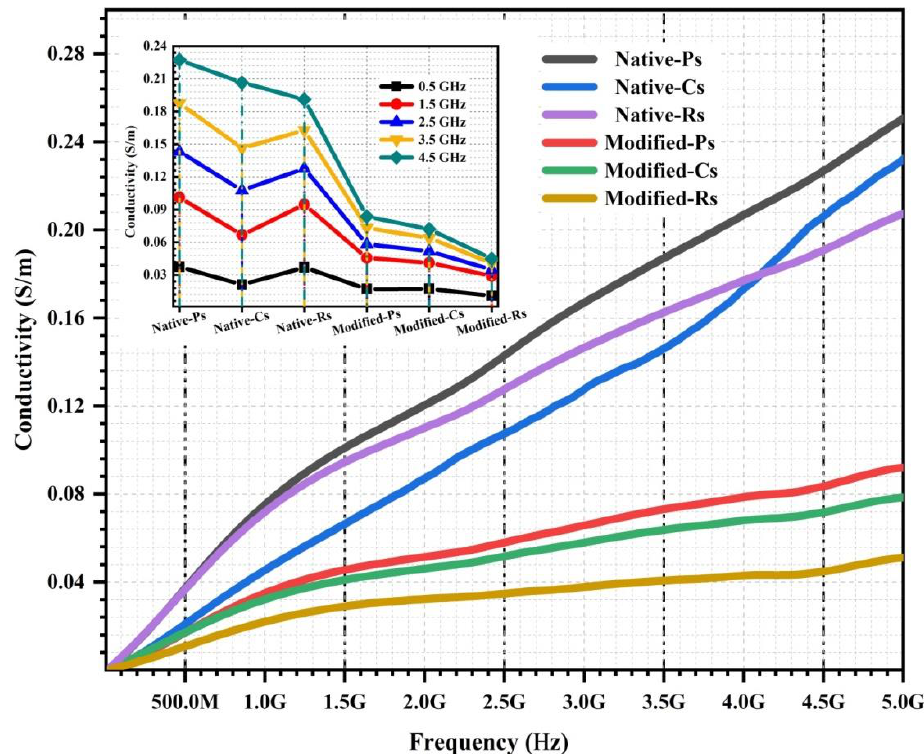
Figure 7. Frequency dependence of σ of native form and modified form of starches over the fre- quency range of 5 Hz–5 MHz.